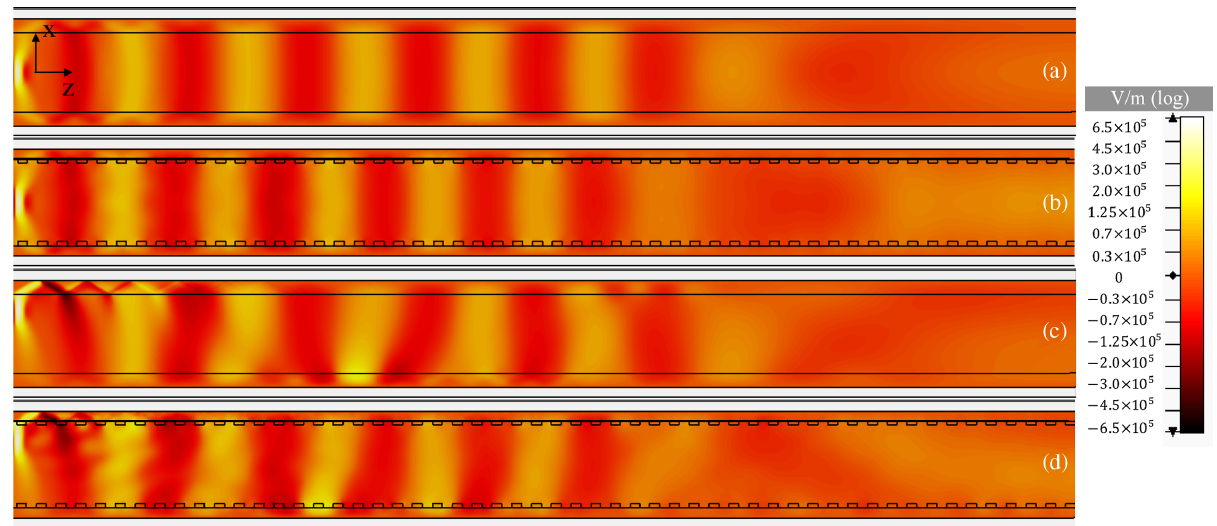
FIG. 3. Field maps for on axis [(a) and (b)] and 1.2 mm off axis [(c) and (d)] beam propagations in